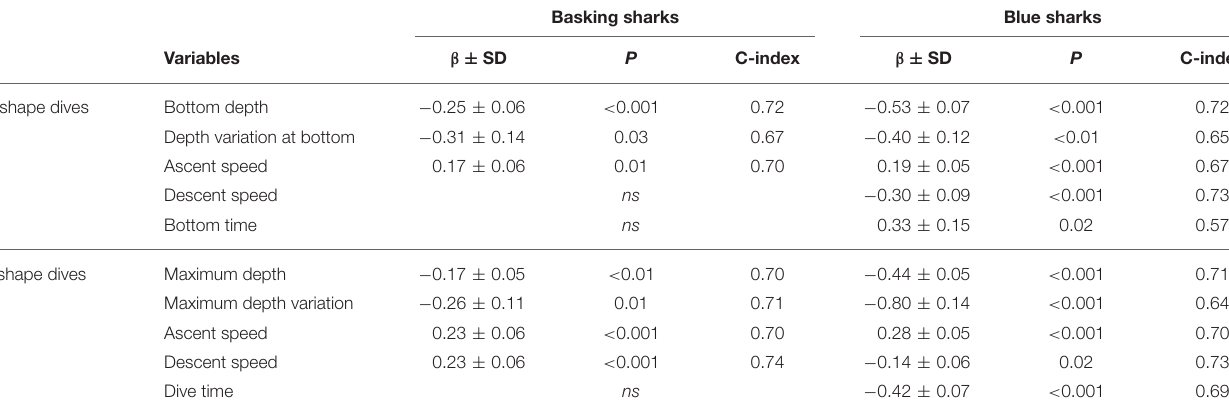
TABLE 4 | Results of the GLMM model for different U and V dive parameters for basking (left) and blue (right) sharks.